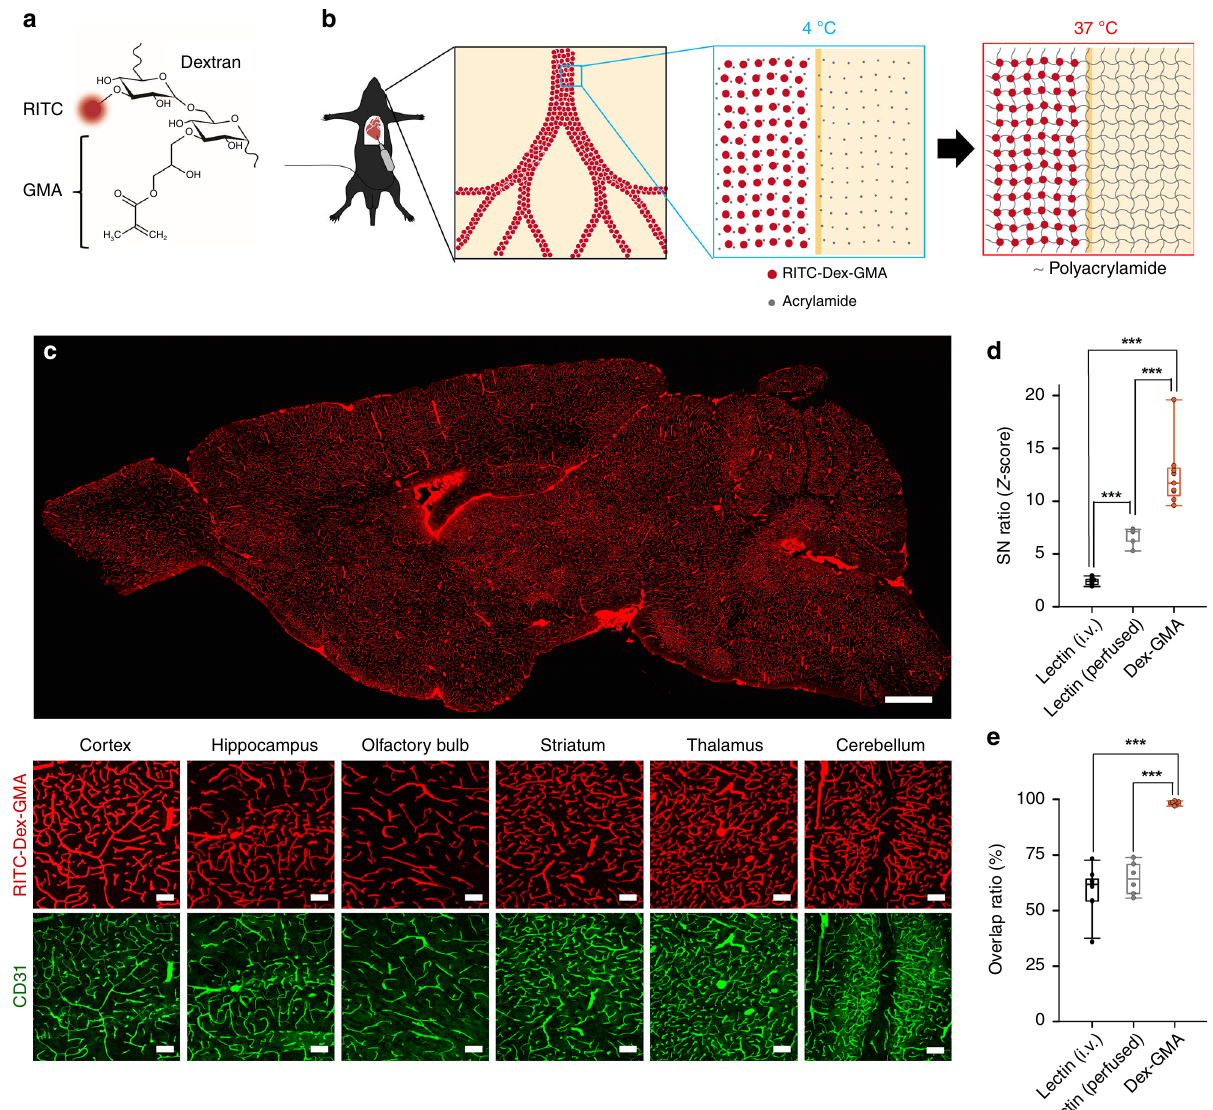
Fig. 1 Near-complete visualization of cerebral vasculature using thermally controlled polymerization of a BBB-impermeable fl uorescent crosslinker. a Design of the BBB impermeable fl uorescent crosslinker RITC – Dex – GMA. The fl uorophore RITC and the crosslinkable group GMA are chemically linked through dextran, a BBB-impermeable molecule. b Strategic concept of vascular casting using a hybrid hydrogel. Red circles and gray dots indicate RITC – Dex – GMA and acrylamide, respectively. c Top: A confocal image of a sagittal section of an adult mouse brain treated with vascular casting using RITC – Dex – GMA, acrylamide, and VA-044. Scale bar = 1 mm. Bottom: Magni fi ed images of RITC – Dex – GMA-casted vasculature of different brain regions (red) and endothelial cells counterstained using anti-CD31 in the same fi elds (green). Scale bar = 100 μ m. d SN ratios of the fl uorescence intensities in lectin-based and Dex – GMA-based visualization ( n = 10, 6, and 9 slices from 10, 6, and 9 mice, respectively; box plots indicate median and 25 – 75% interquartile ranges; whiskers cover 10 − 90% quantiles. P = 2.94 × 10 − 10 , F 2,22 = 69.9, one-way ANOVA; Dex-GMA versus lectin (i.v.); *** P = 1.59 × 10 − 10 , Q = 16.7; Dex – GMA versus lectin (perfused); *** P = 2.01 × 10 − 5 , Q = 8.27; lectin (i.v.) versus lectin (perfused): *** P = 4.53 × 10 − 4 , Q = 6.42, 2,22 2,22 2,22 Tukey ’ s test). e Overlap ratios between anti-CD31 immunoreactivity and Texas Red/RITC fl uorescence in lectin-based and Dex – GMA-based visualization (59.4 ± 9.45%, 64.4 ± 7.32%, and 98.2 ± 0.8%, mean ± SD of 10, 6, and 9 slices from 10, 6, and 9 mice, respectively; box plots indicate median and 25 − 75% interquartile ranges; whiskers cover 10 − 90% quantiles. P = 1.59 × 10 − 10 , F = 74.5, one-way ANOVA; Dex – GMA versus lectin (i.v.); *** P = 2,22 2.39 × 10 − 10 , Q 2,22 = 16.4; Dex – GMA versus lectin (perfused); *** P = 3.51 × 10 − 8 , Q 2,22 = 12.4; lectin (i.v.) versus lectin (perfused): P = 0.401, Q 2,22 = 1.86, Tukey ’ s test). Source data are provided as a Source Data fi